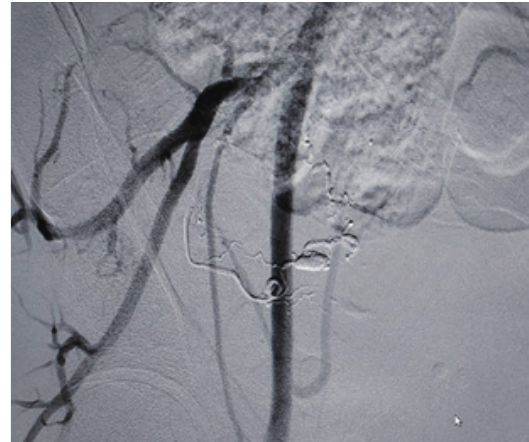
Figure 6 Post-treatment arteriographic study demonstrating adequate embolization of the pseudoaneurysm.